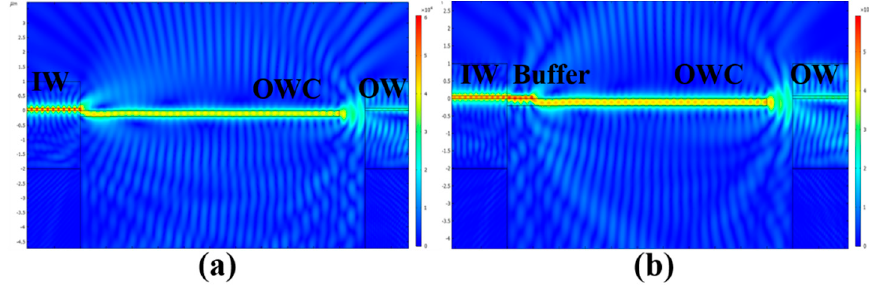
Figure 3. Electric field distribution for the input waveguide and cantilever of (a) the conventional structure and (b) the improved structure with a buffer.